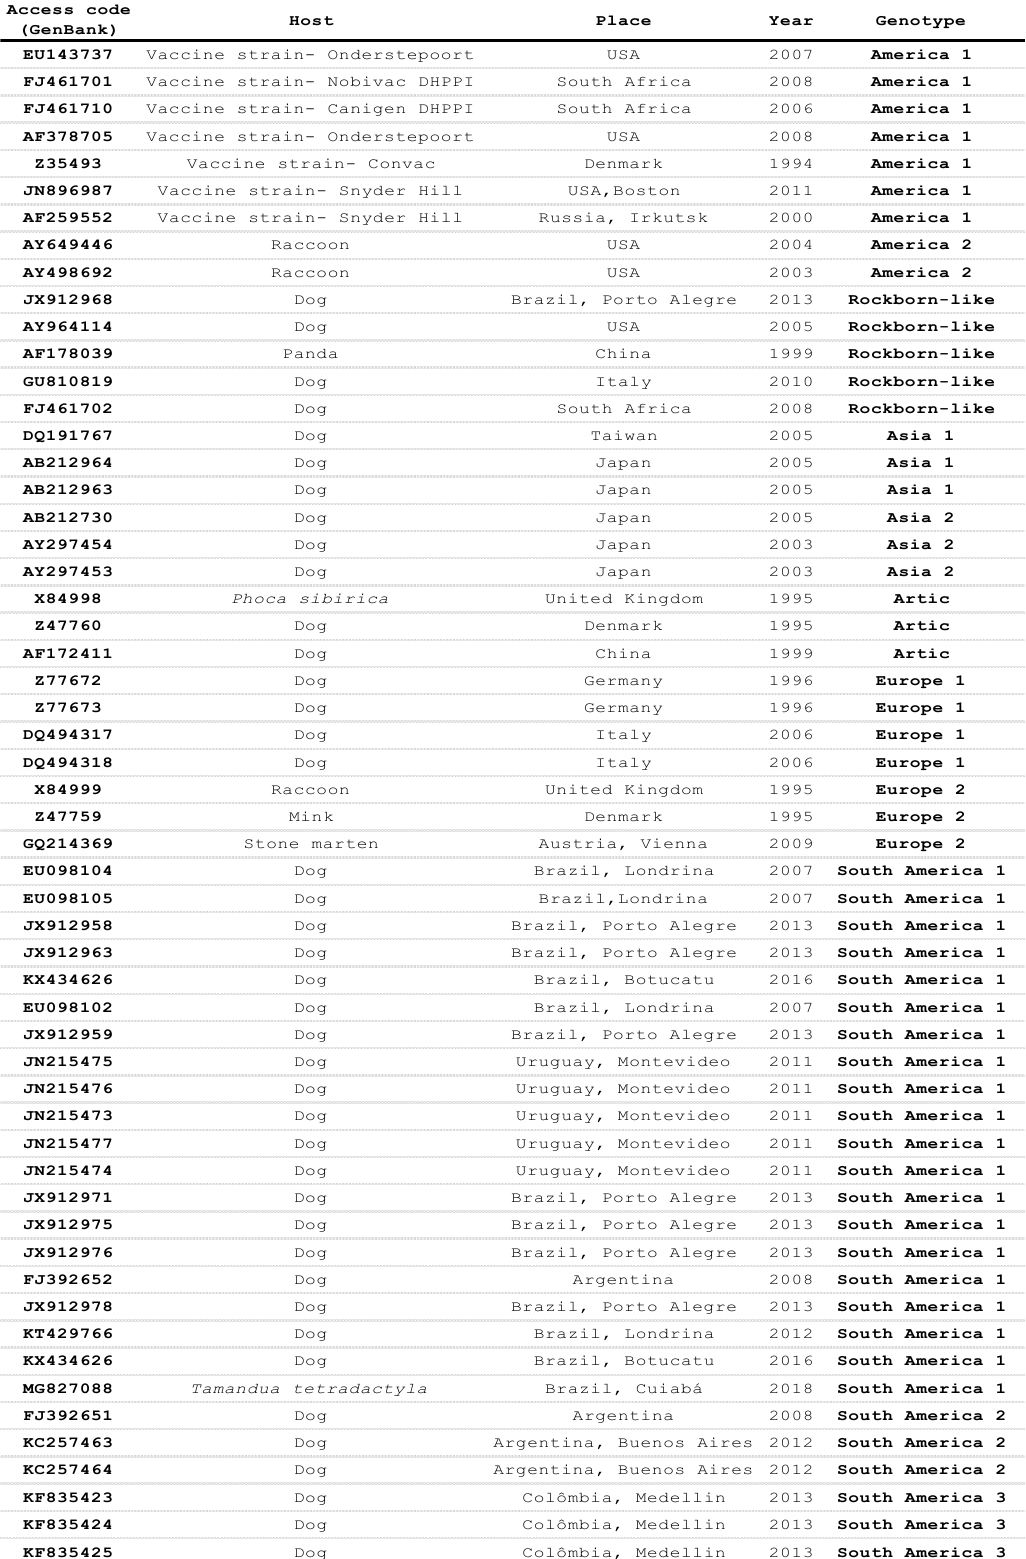
Table 3: Detail of nucleotide sequences by genogroup with GenBank accession codes, used to create the phylogenetic tree for this